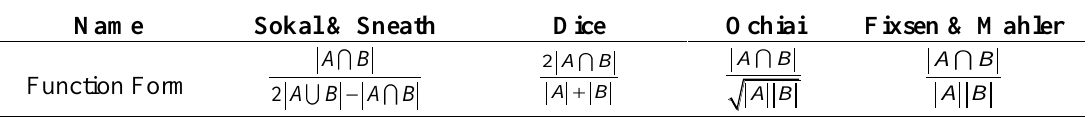
Table 2. Different consistency measure